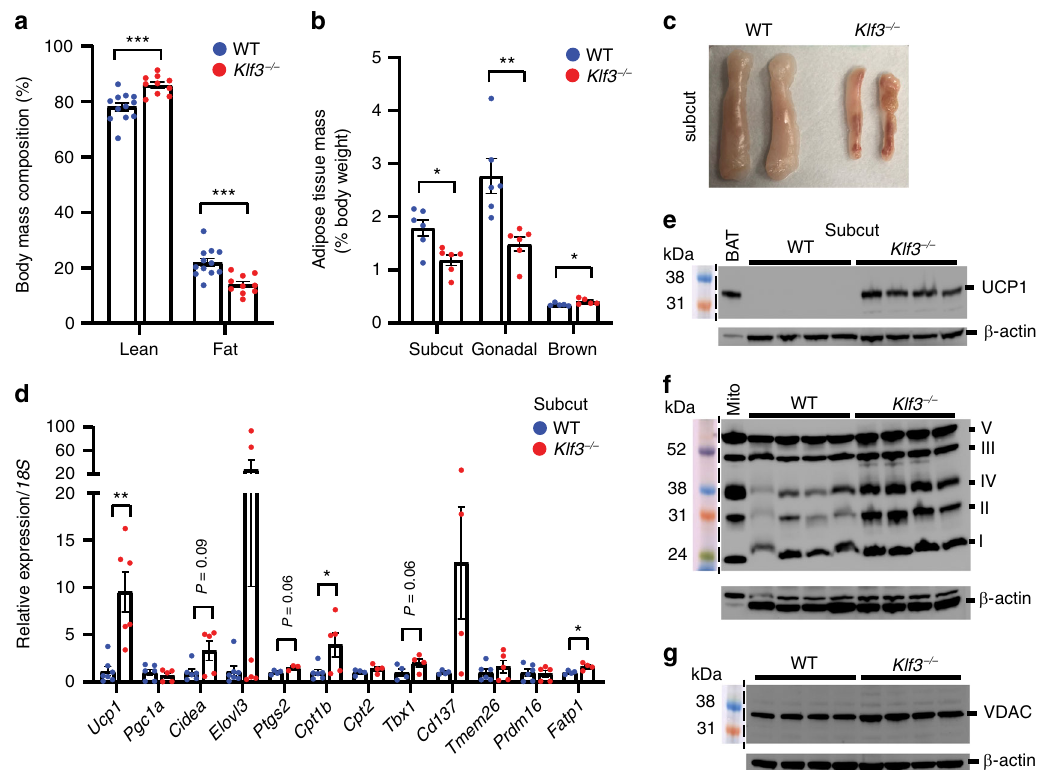
Fig. 1 Reduced adiposity and enhanced beiging in Klf3 − / − mice. a Lean and fat body mass composition (%) of WT ( n = 12) and Klf3 − / − ( n = 10) mice were assessed by EchoMRI analysis. b Weights of WT and Klf3 − / − AT depots were recorded as a percentage of total body weight ( n = 6 mice for subcut and gonadal AT; n = 5 mice for brown AT). c Representative macroscopic images of WT and Klf3 − / − subcut AT pads showing relative size and complexion. d mRNA levels of thermogenic genes were assessed by qPCR in WT and Klf3 − / − subcut AT ( n = 4 – 8 mice). Relative expression was normalised to 18S rRNA levels and the mean WT value for each gene was set to 1. e UCP1 protein expression was measured in WT and Klf3 − / − subcut AT by western blotting ( n = 4 mice). 25 μ g of whole-cell extract (WCE) was loaded alongside a Rainbow molecular weight marker. Nitrocellulose membranes were probed with anti-UCP1 antibody overnight. Diluted brown adipose tissue (BAT) extract included as a positive control. f Expression of mitochondrial oxphos proteins in WT and Klf3 − / − subcut AT WCE was assessed by western blotting ( n = 4 mice). 25 μ g of extract was loaded alongside rat heart mitochondria extract (Mito; positive control), and PVDF membranes were blocked overnight before being probed with the Total OXPHOS Rodent WB Antibody Cocktail for 2 h. Mitochondrial complexes are labelled by their Roman numerals (I – V). g VDAC protein expression was measured in WT and Klf3 − / − subcut AT ( n = 4 mice) by western blotting. 20 μ g of WCE was loaded and nitrocellulose membranes were probed overnight with anti-VDAC antibody. For e – g β -actin was included as a loading control. For a , b and d , error bars represent means ± SEM and one-sided non-parametric Mann – Whitney U tests were performed where * P < 0.05, ** P < 0.01, *** P < 0.001. Source data are provided as a Source data fi le. kDa, kilodaltons. See also Supplementary Figs. 1 and